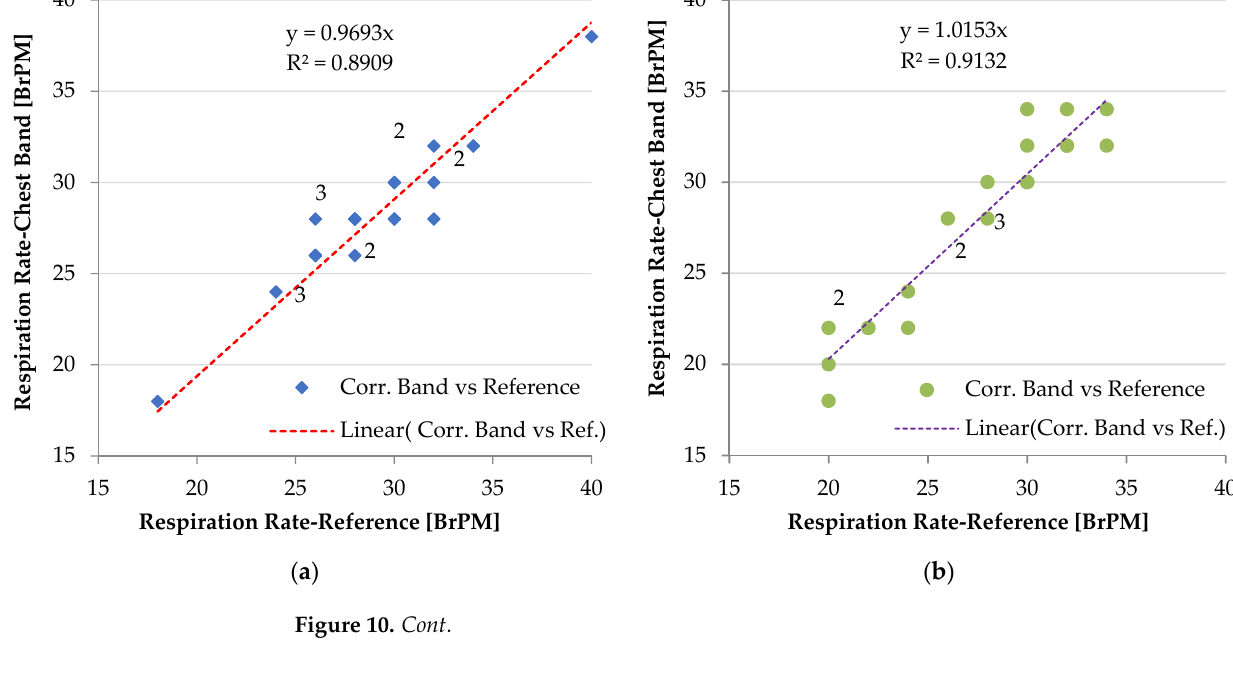
( c ) Figure 10. Correlation diagrams of RR measurements obtained by the developed piezoresistive chest band and counting the number of breaths, considering three different operating conditions: seated user ( a ), standing user ( b ), and user walking at 1 ms − 1 ( c ). The multiplicity of the data points is indicated in the graph. Pearson correlation coefficients were calculated between the RR measurements ob- tained with the developed chest band and those measured by counting breaths (Equation (11)): r= n( ∑ RR Band RR Man )-( ∑ RR Band )( ∑ RR Man ) (cid:3495)(cid:3427) n ∑ RR 2 Band - (cid:4666)∑ RR Band (cid:4667) 2 (cid:3431)(cid:3427) n ∑ RR 2 Man - (cid:4666)∑ RR Man (cid:4667) 2 (cid:3431) (11) Furthermore, the Bland–Altman graphs of the measurements obtained by the pie- zoresistive chest band and those obtained by counting breaths are depicted in Figure 11 for different operative conditions (i.e., seated, standing, and walking). This graph allows